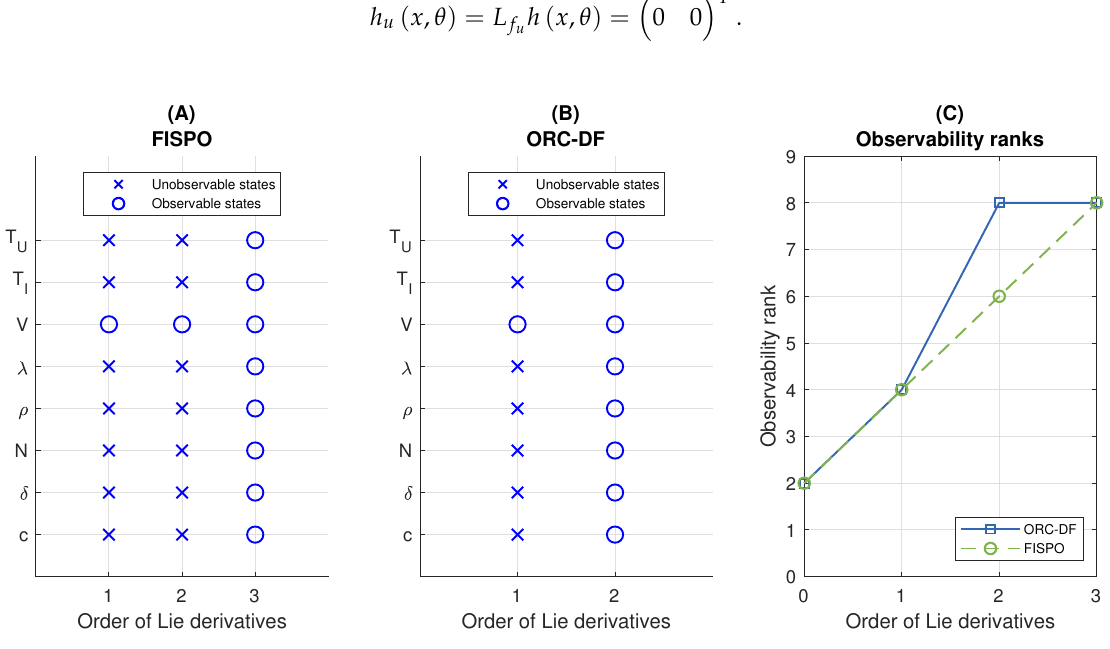
Figure 5. Analysis of the HIV model with the FISPO and ORC-DF algorithms, with the input η ( t ) considered known. ( A , B ) Results of the FISPO and ORC-DF algorithms, respectively: the panel shows the states classified as observable or unobservable as a function of the number of Lie derivatives calculated by each algorithm. ( C ) Observability rank obtained by each algorithm as a function of the number of Lie derivatives. The full rank is equal to the number of states, i.e.,